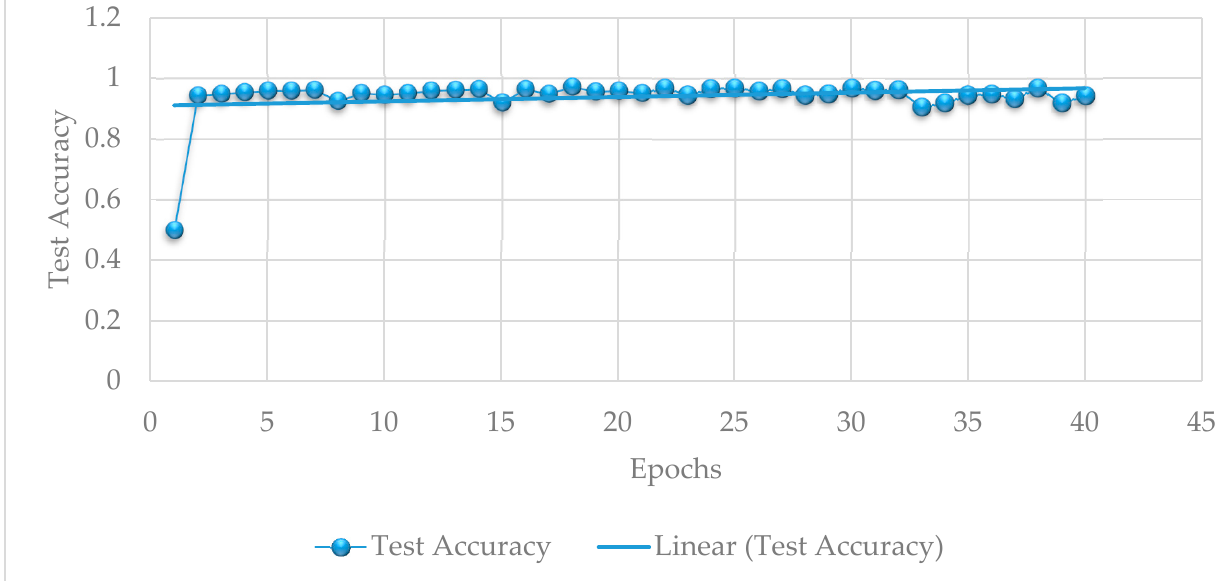
Figure 10. Graph showing test accuracy vs. epoch characteristics.